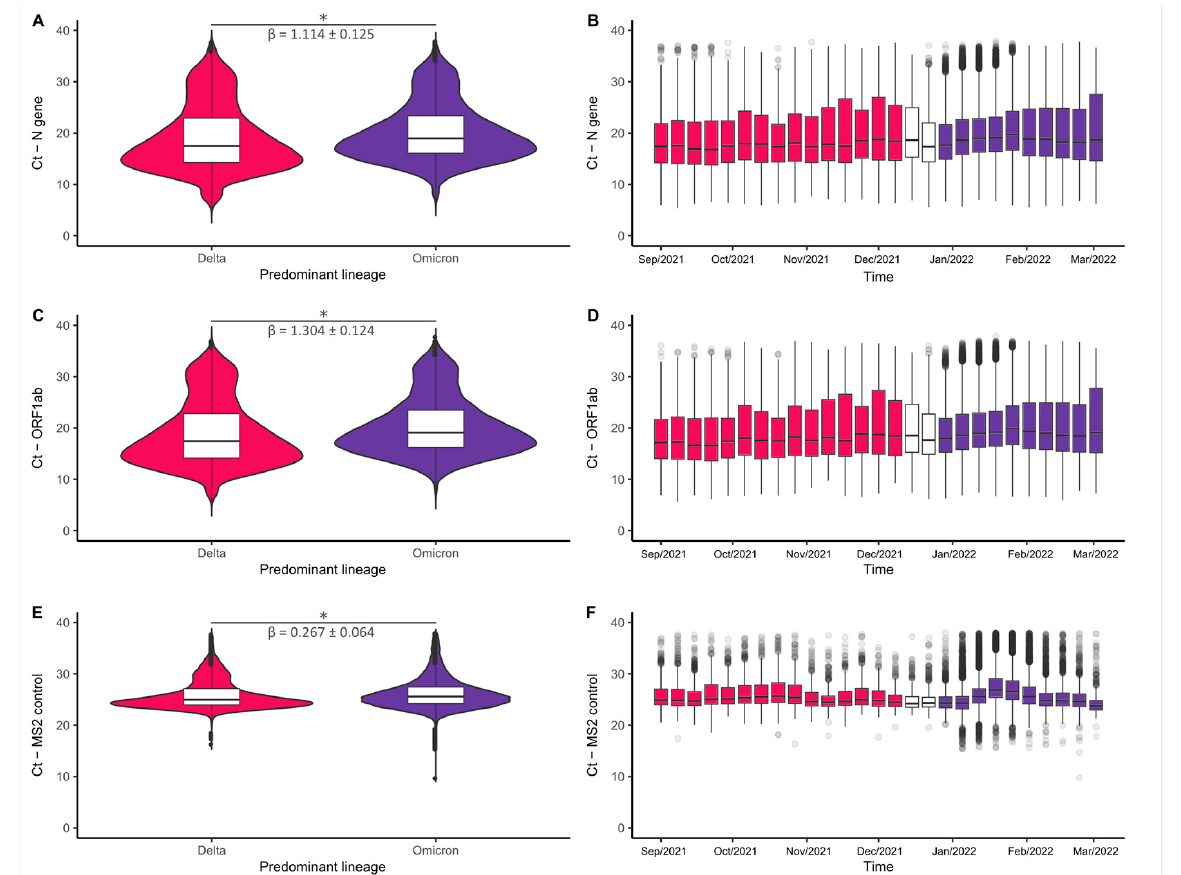
Figure 4. Comparative analysis of RT-qPCR Ct values between Delta and Omicron SARS-CoV-2 VOC dominance periods. Colors represent the dominant variant, with a frequency above 90% in the analyzed period, being Delta (red) or Omicron (dark purple). Violin plots displaying the distribution of Ct data according to the predominant lineage for the viral target genes N ( A ) and ORF1ab ( C ), and the MS2 internal process control ( E ). Boxplots display Ct value variation along the epidemiological weeks comprised in the study period (August 29, 2021–March 5, 2022) for the viral target genes N ( B ), ORF1ab ( D ), and MS2 internal control ( F ). A statistical comparison between periods denotes that Omicron VOC might be associated with lower viral loads in the upper respiratory tract than Delta VOC infection. White bars represent the first quartile, the median and the third quartile. Black circles represent the outliers * p < 0.001.